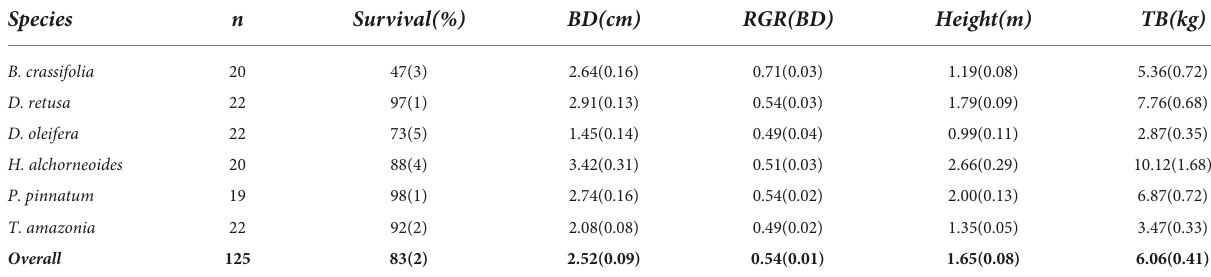
TABLE 4 Mean ( SE ) survival and growth for the six study species (and all species overall, bold) across all control (i.e., no annual fertilization) plots within all planting areas at 30 months post-planting. Species